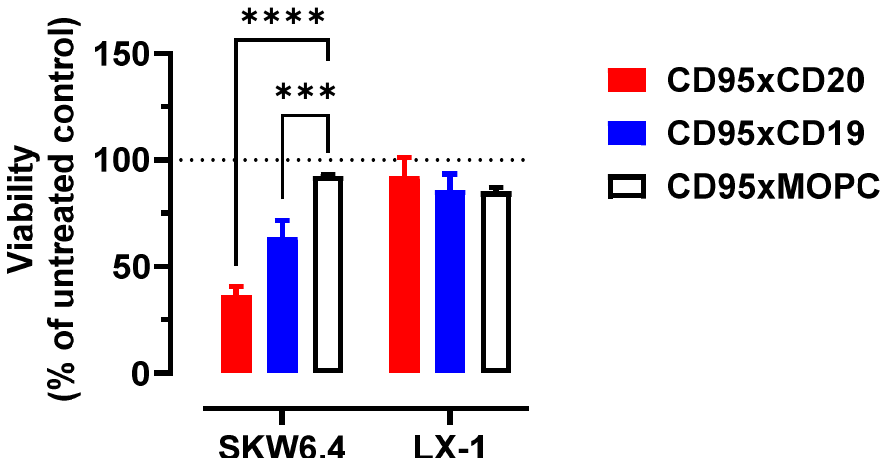
Figure 5. Bispecific anti-CD95 antibodies induce apoptosis in activated lymphocytes (type I cells) but not in hepatocytes (type II cells). SKW6.4 lymphoma cells and LX-1 hepatic stellate cells were co-cultured for 20 h before the depletion of both cell populations was determined by flow cytometry. Statistics were calculated with two-way ANOVA. Treatment versus isotype control. Mean ± SD, n = 3. *** p < 0.001, **** p < 0.0001.